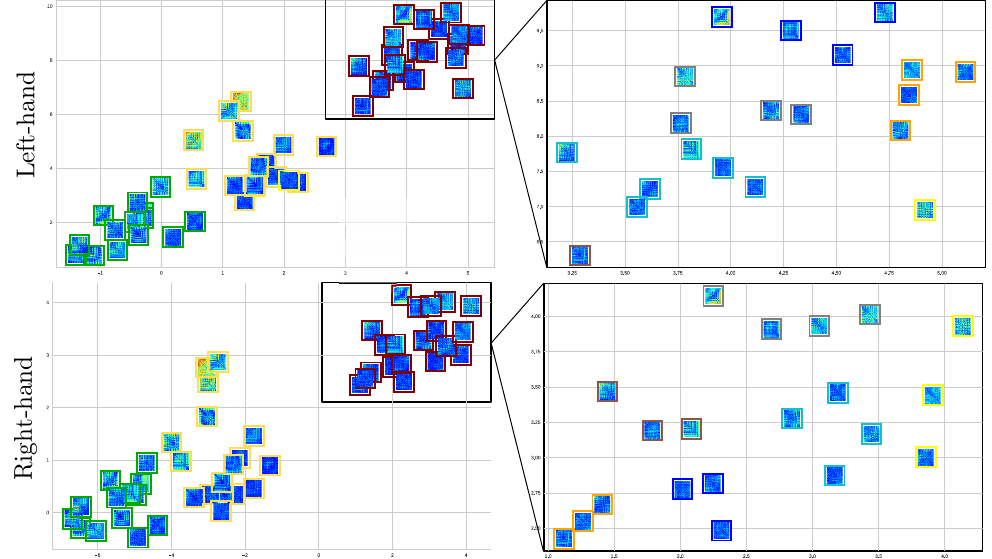
Figure 9. Clustering of motor skills obtained by the CNN-based approach with connectivity features for each MI task. ( Left side ): Subject partitions are colored for each subject group: GI (green squares), GII (yellow), and GIII (red). ( Right side ): Detailed analysis of the worst-performing GIII by splitting all the participants into subgroups, fixing k =